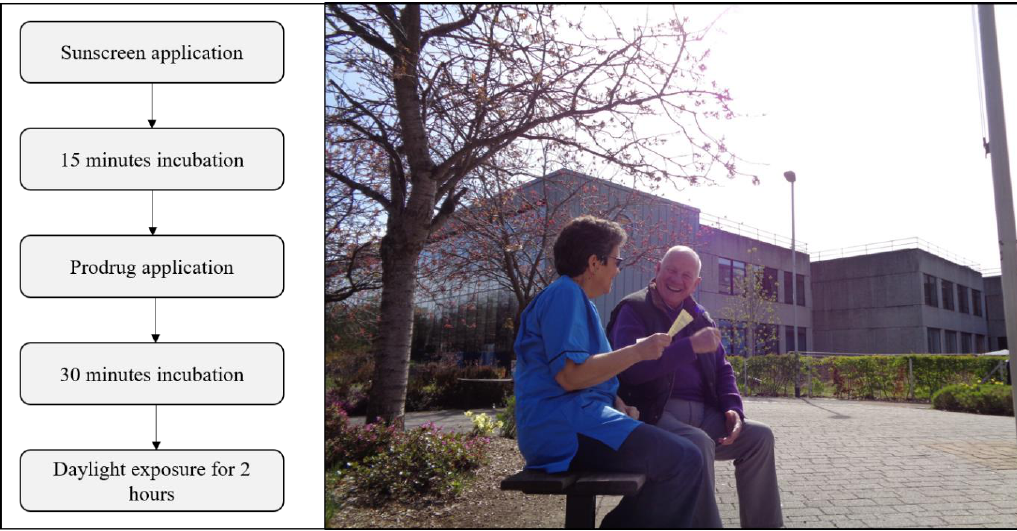
Figure 1. ( Left ): flowchart of the successful daylight photodynamic therapy (DPDT) protocol. ( Right ): patient receiving information before DPDT at Ninewells Hospital, Dundee.